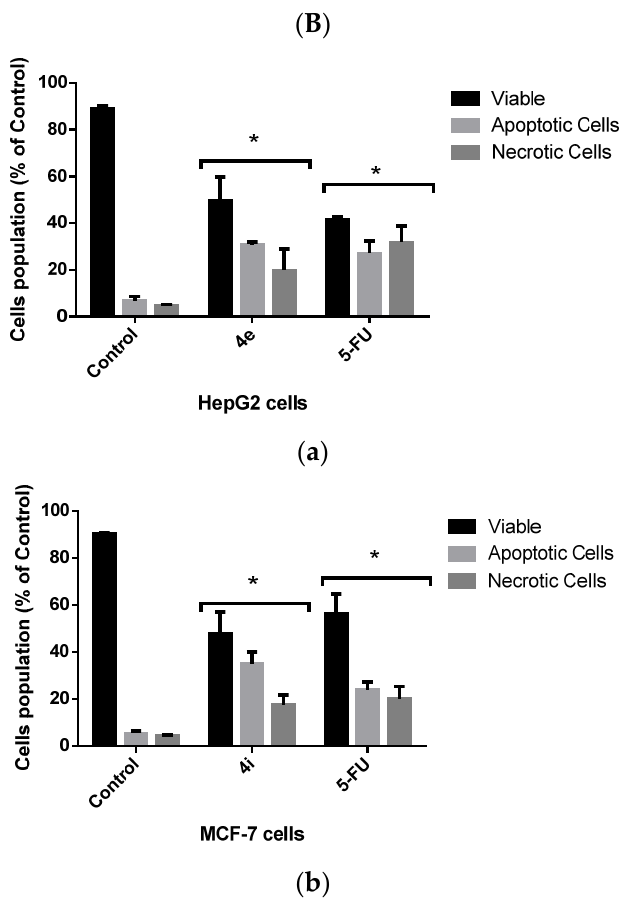
Figure 4. ( A ) HepG2 and MCF-7 cells were stained with the AO/EB fluorescent dye to distinguish between different cell populations: live (green), apoptotic (yellow to light orange), and necrotic cells (dark orange to red) and viewed under a fluorescence microscope. ( B ) The percentage of distinct cell populations in HepG2 ( a ) and MCF-7 cells ( b ). * p < 0.05